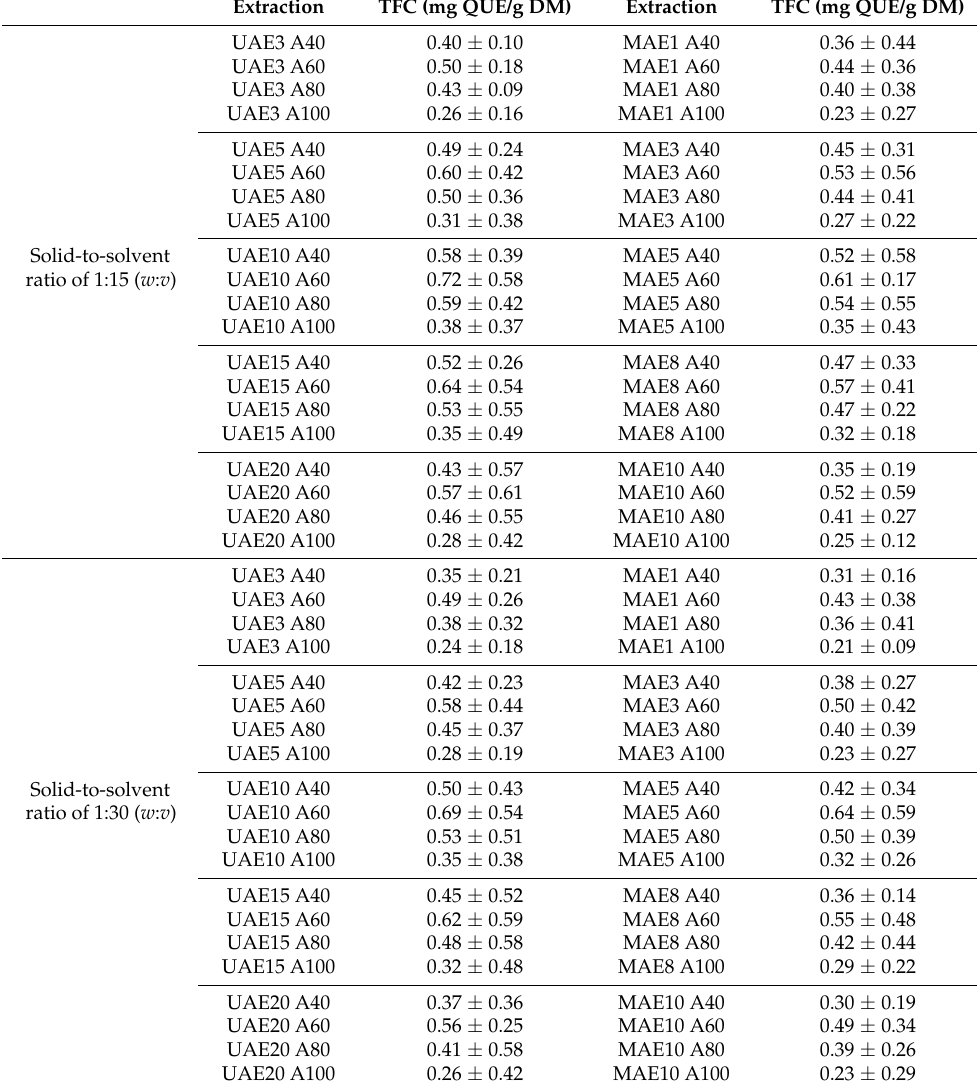
Table 1. TFC that was extracted from distillery stillage with UAE and MAE. In the abbreviations used to refer to the series, the values after UAE and MAE indicate the extraction time; the values after A (acetone) show the solvent